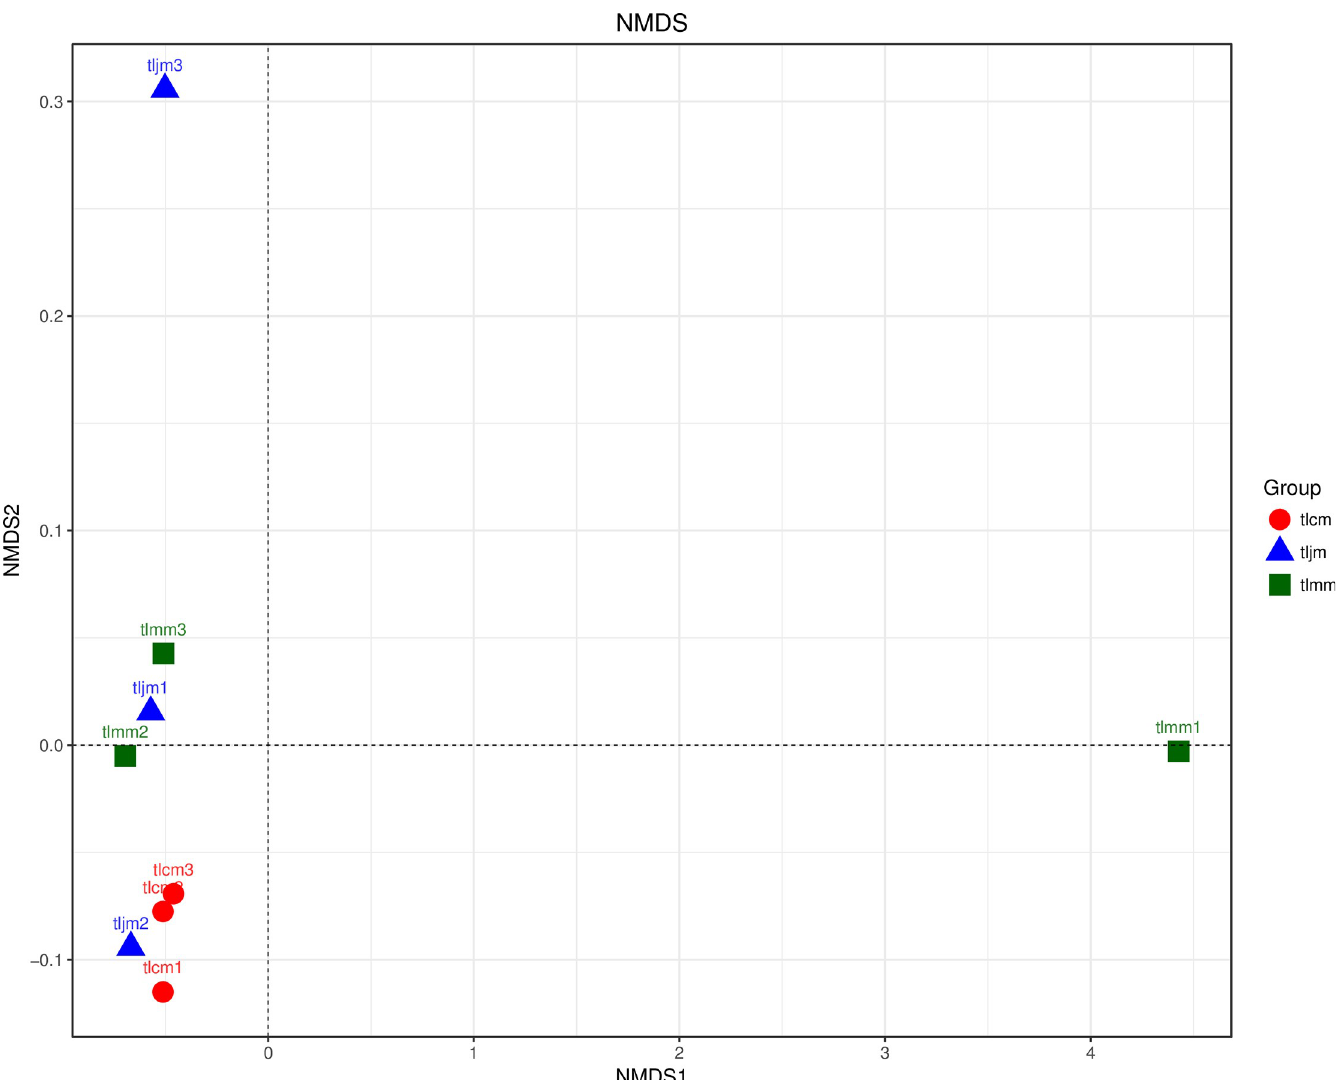
Fig 5. NMDS analysis of the bacterial lactase gene from intestinal mucosa. Different color points represent samples from different groups. The closer distance between the two points represented the smaller the community difference of the lactase-produced bacteria between the two samples. tlcm, tlmm and tljm represent the healthy control group, the diarrhea model group and the D . hansenii treatment group